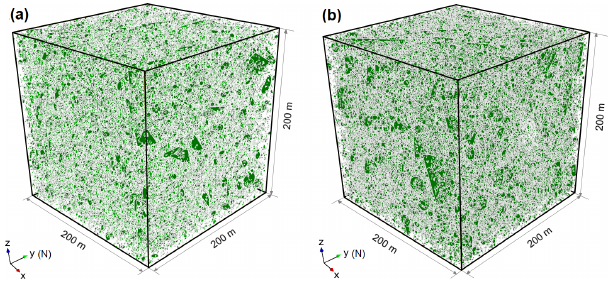
Figure 7. Illustration of DFN models with 1% open fractures for (a) the Borstein quarry ( n = 214287) and (b) the Weschnitz Valley quarry ( n = 279787).